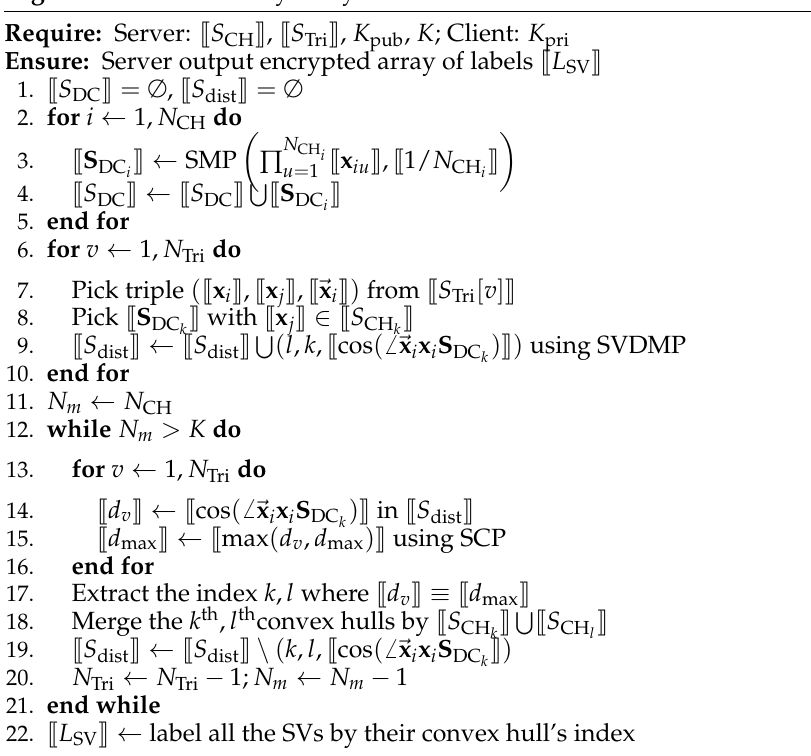
Algorithm 6 details the privacy-preserving connectivity analysis with K . Lines 1–5 construct the density centroid for each convex hull. For efficiency, we suggest the client supplying [[ 1/ N CH framework of SMP to avoid an additional division protocol. Based on SVDMP, Lines 6–10 obtain the included angel cosine for each convex hull and its nearest SV of the nearest neighbor. Then, Lines 11–21 merge the nearest convex hulls pair one by one, until the final cluster number reaches K . The last line labels all the other SVs directly. Similar operations are in Algorithm 7. The major difference is Line 4, which compares [[ d v ]] with [[ η 2 ]] using SCP to determine the